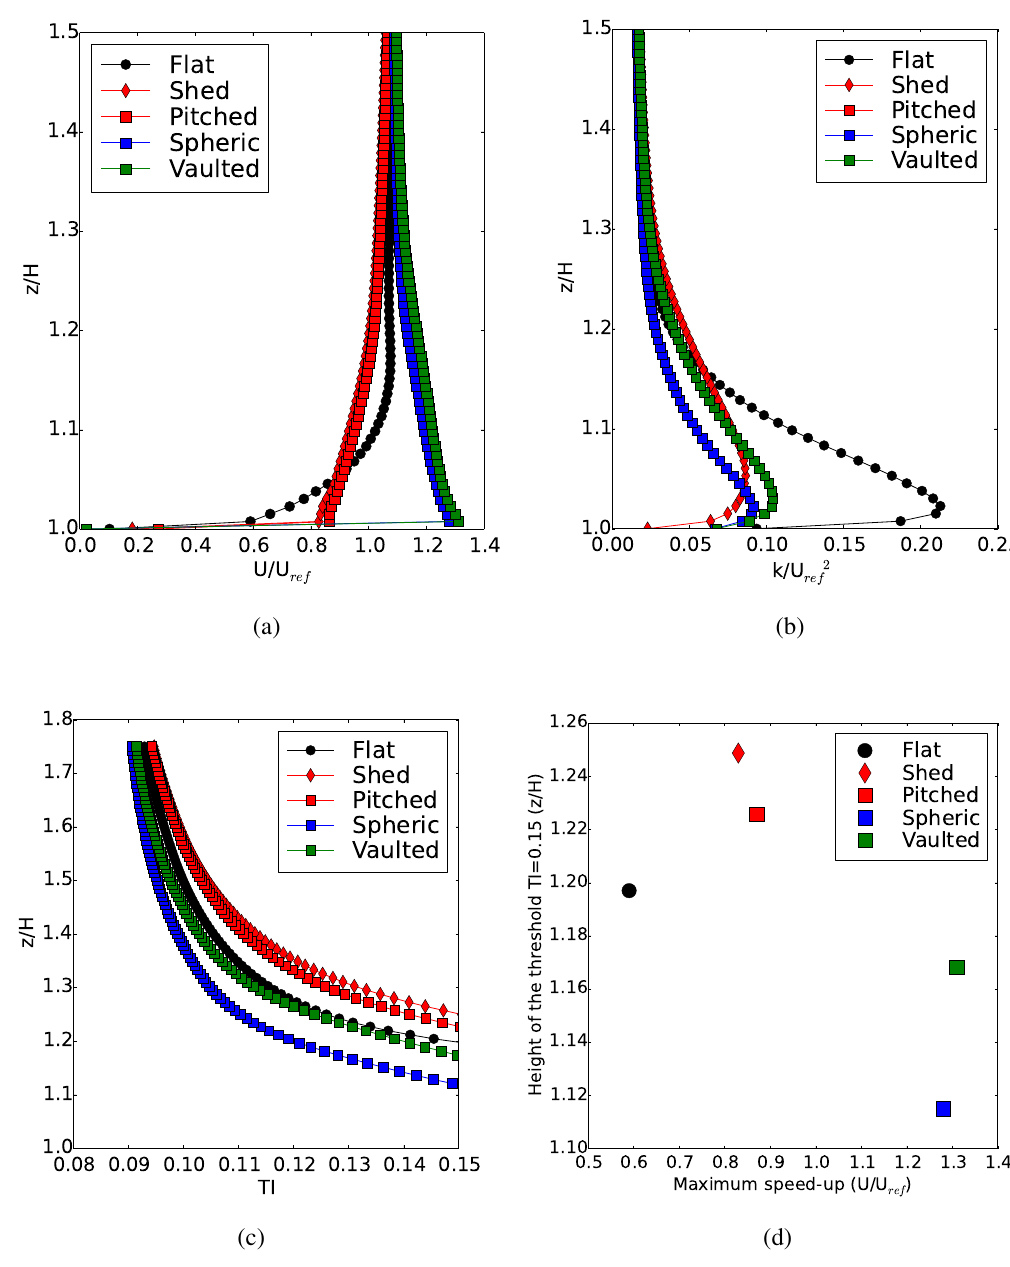
Figure 11. Comparison of U , k and T I for the state-of-the-art cases at the most advantageous vertical axis for each case: upstream edge for the flat roof, downstream edge for the shed roof and center of the roof for the rest of the shapes. ( a ) Comparison of U ; ( b ) comparison of k ; ( c ) comparison of T I below the limit of T I < 0 . 15 ; ( d ) comparison of the speed-up ( U/U ) and the T I threshold ref